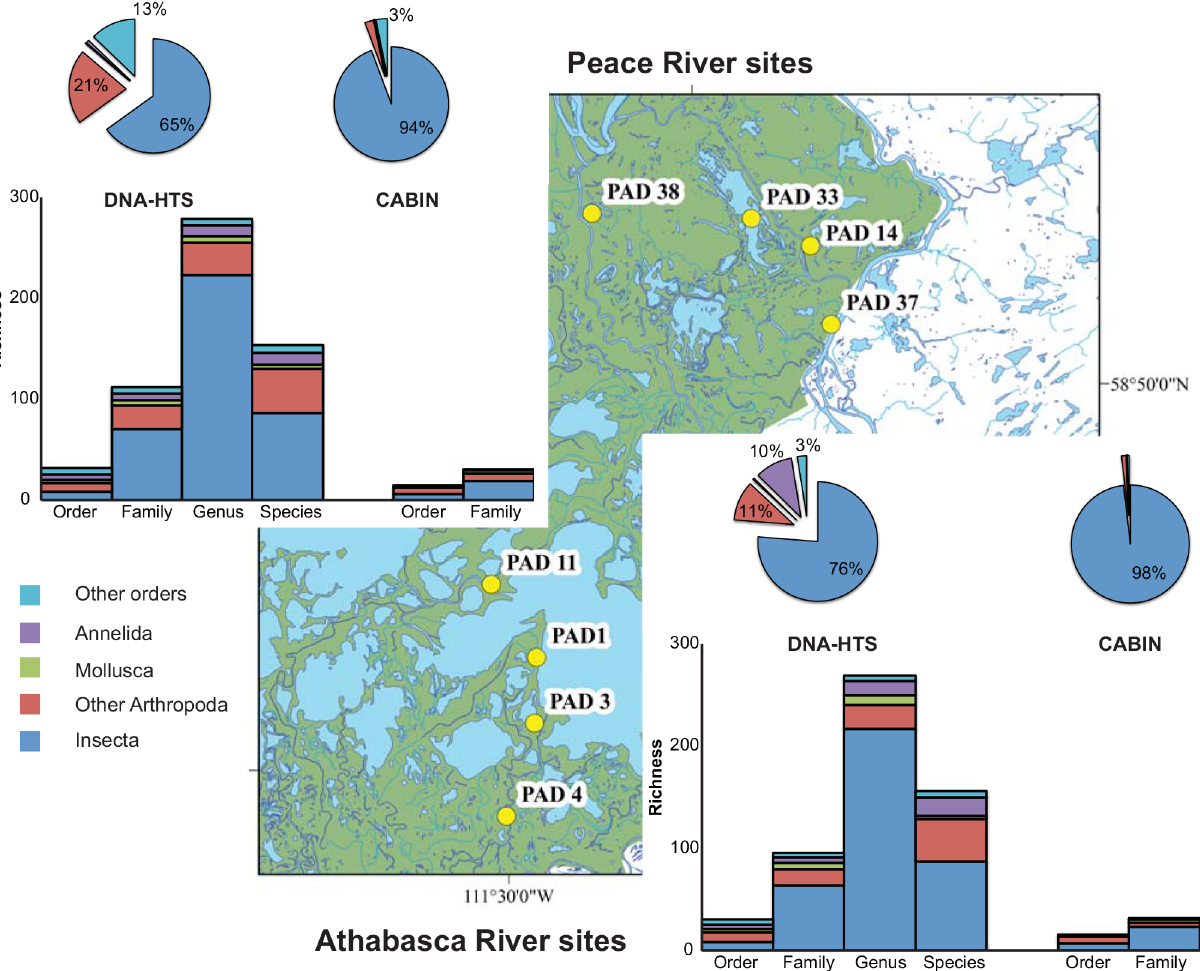
Fig 5. Gamma diversity recovered from Athabasca River and Peace River sites at six different taxonomic levels via morphological identification (CABIN) and molecular methods (DNA-HTS). Column charts represent taxonomic richness separated by major groups and taxonomic levels. Pie charts represent proportion of observations (sequences or individuals) identified to the order level assigned to each major